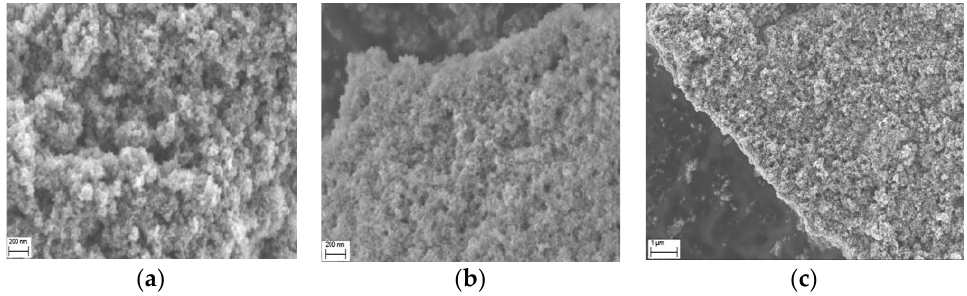
Figure 2. SEM images of ( a ) sample 1 with 1 mL waste ALS, ( b ) sample 2 with 2.5 mL waste ALS, and ( c ) sample 3 with 5 mL waste ALS.